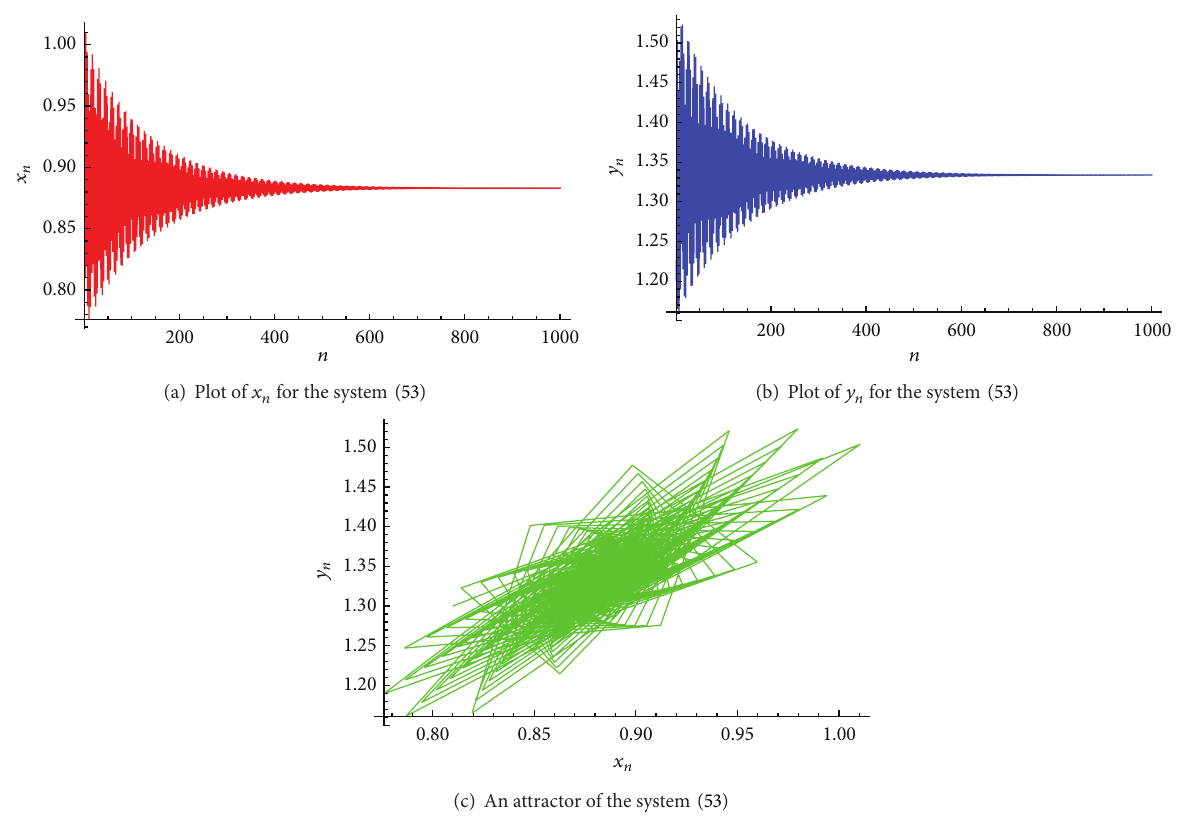
Figure 4: Plots for the system